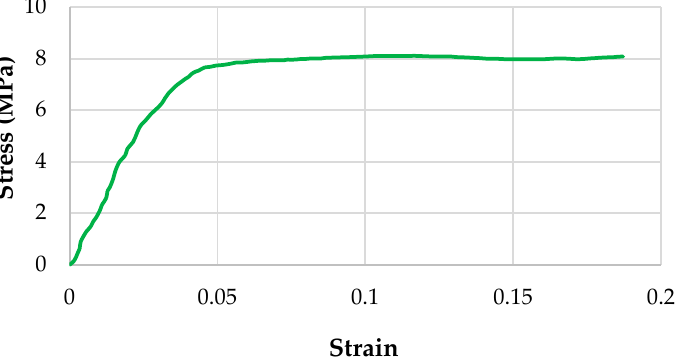
Figure 5. Proposed material properties from combined compression–shear stress–strain relationships used in all simulations.